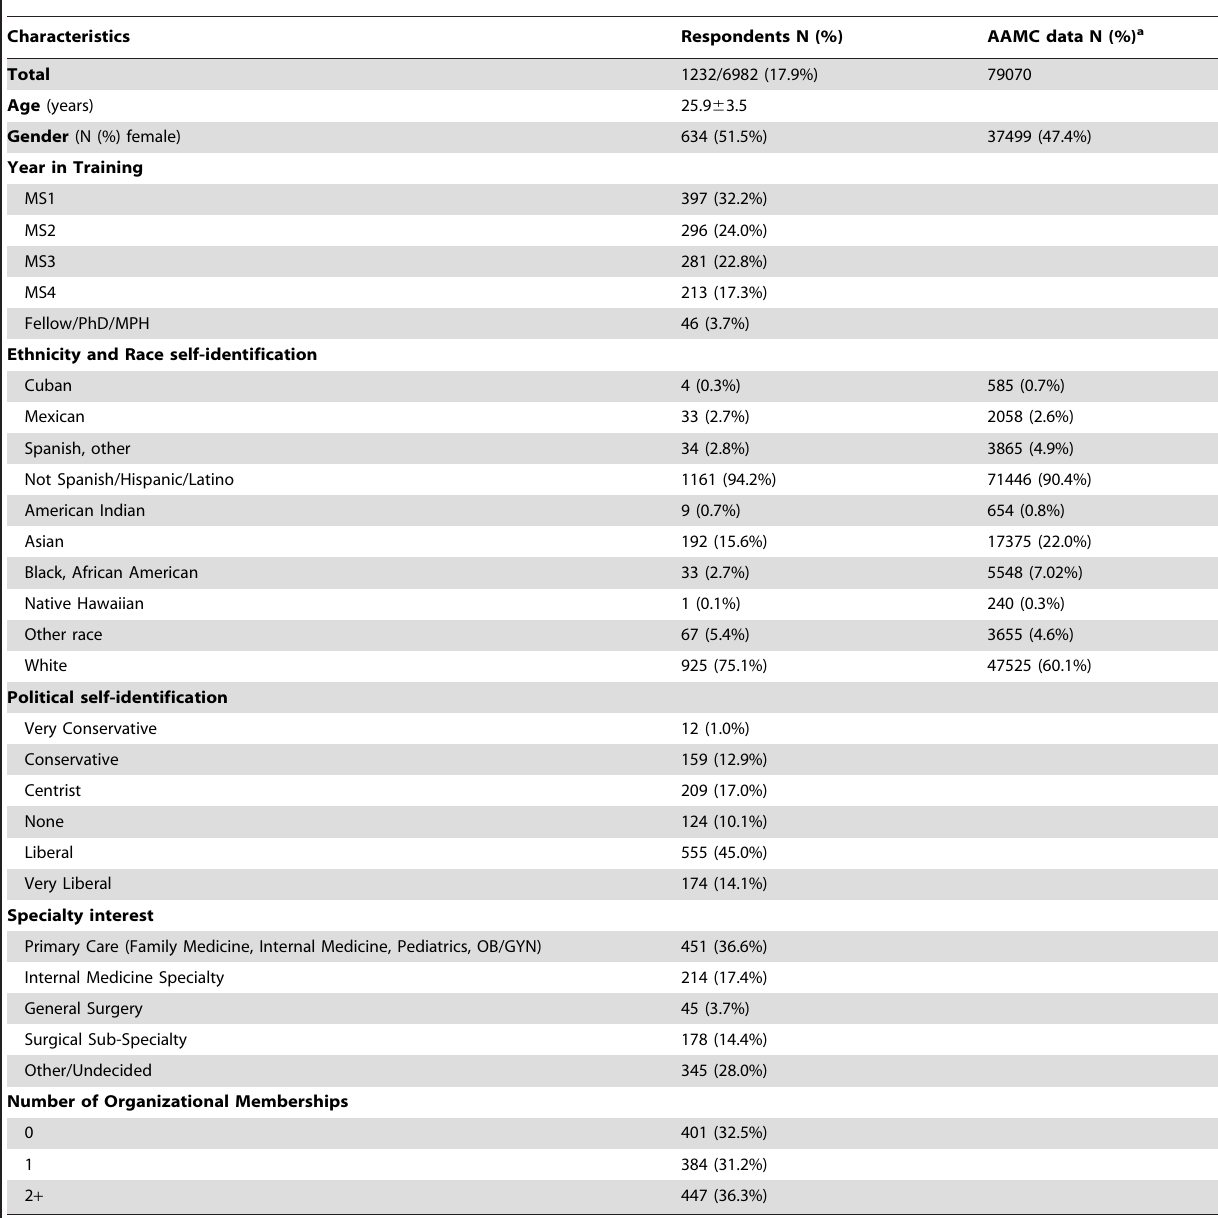
Table 1. Demographic Characteristics of